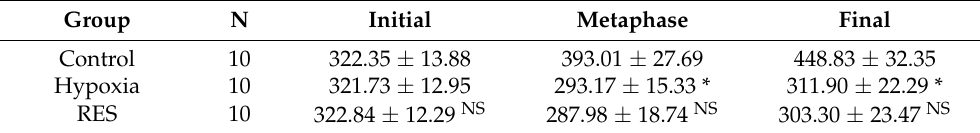
Table 1. Effect of oral administration of RES on body weight (g, X ±